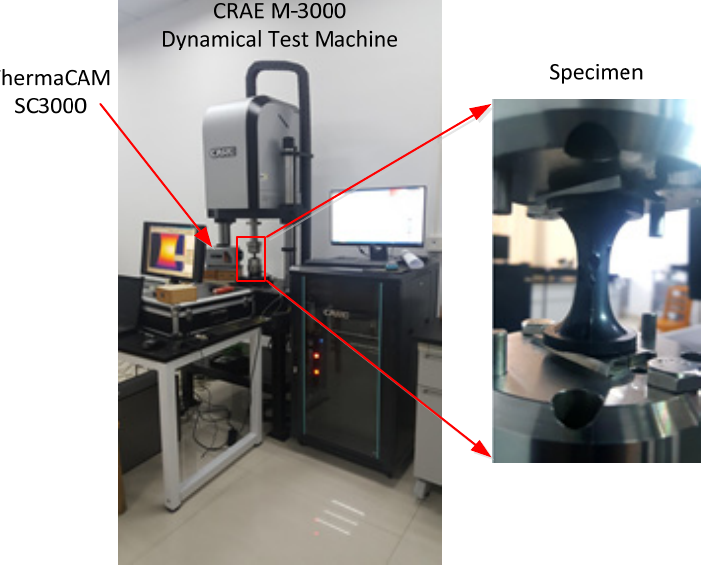
Figure 1. Test setup for fatigue and infrared thermal imaging measurement.